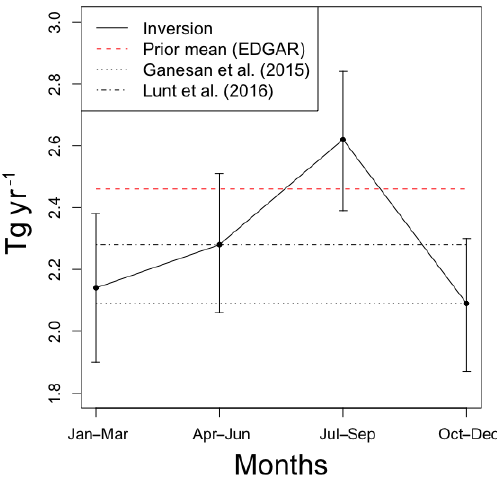
Figure 7. Estimated total UK methane emissions for 2014. The prior mean comes from EDGAR v4.32 inventory data (red dashed). For comparison, the figure also shows the posterior means for UK methane emissions from Ganesan et al. (2015) (black dotted) and Lunt et al. (2016) (black